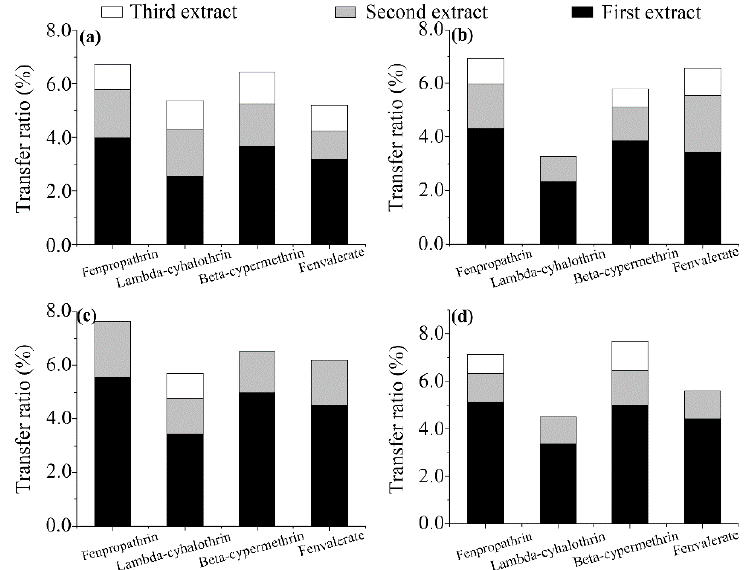
Figure 3. Effect of infusion time on the transfer ratios of the four pyrethroid residues from wolfberry ( a ); licorice ( b ); honeysuckle ( c ); and chrysanthemum ( d ) tea to infusion. Missing white bars denote that no corresponding residues were detected in the third infusion.